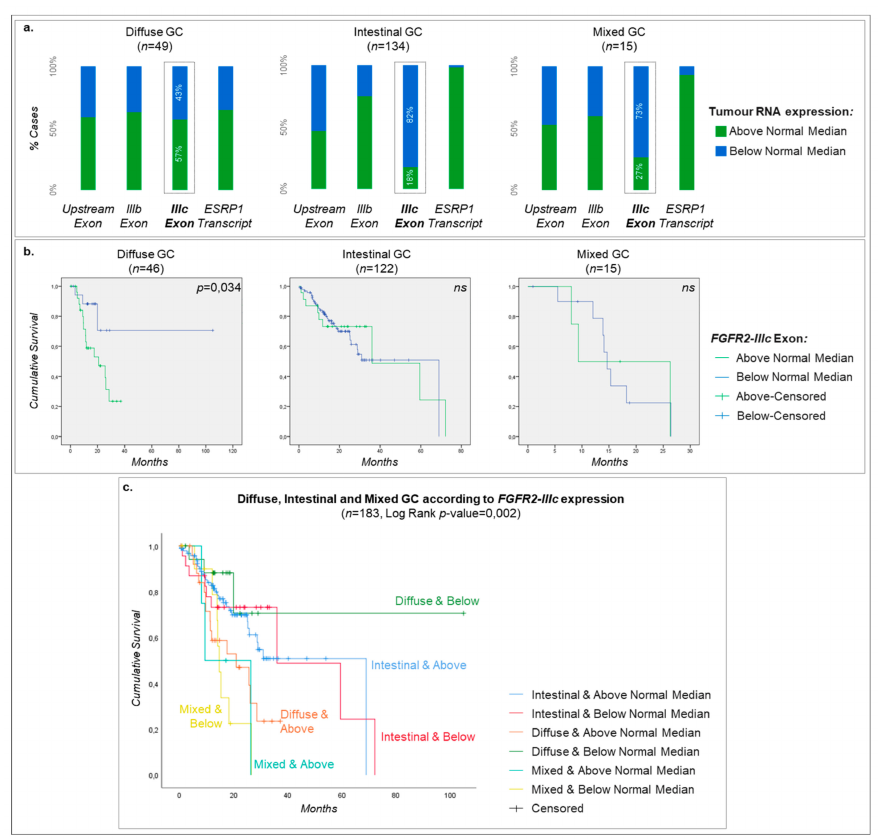
Figure 4. Correlation between FGFR2-IIIc expression and clinico-pathological features. ( a ) Percentage of GC (cohort #1 dataset #11) divided according to the Lauren Classification (Di ff use, Intestinal or Mixed) displaying RNA expression of FGFR2 upstream and downstream exons, FGFR2-IIIb or FGFR2-IIIc specific exons above (green) or below (blue) the normal stomach median expression. ( b ) Individual Kaplan-Meier plots for di ff use, intestinal or mixed GC separated according to FGFR2-IIIc specific exon expression (above / below the median of normal stomach). ( c ) Kaplan-Meier plot for di ff use, intestinal or mixed GC separated according to FGFR2-IIIc specific exon expression (above / below the median of normal